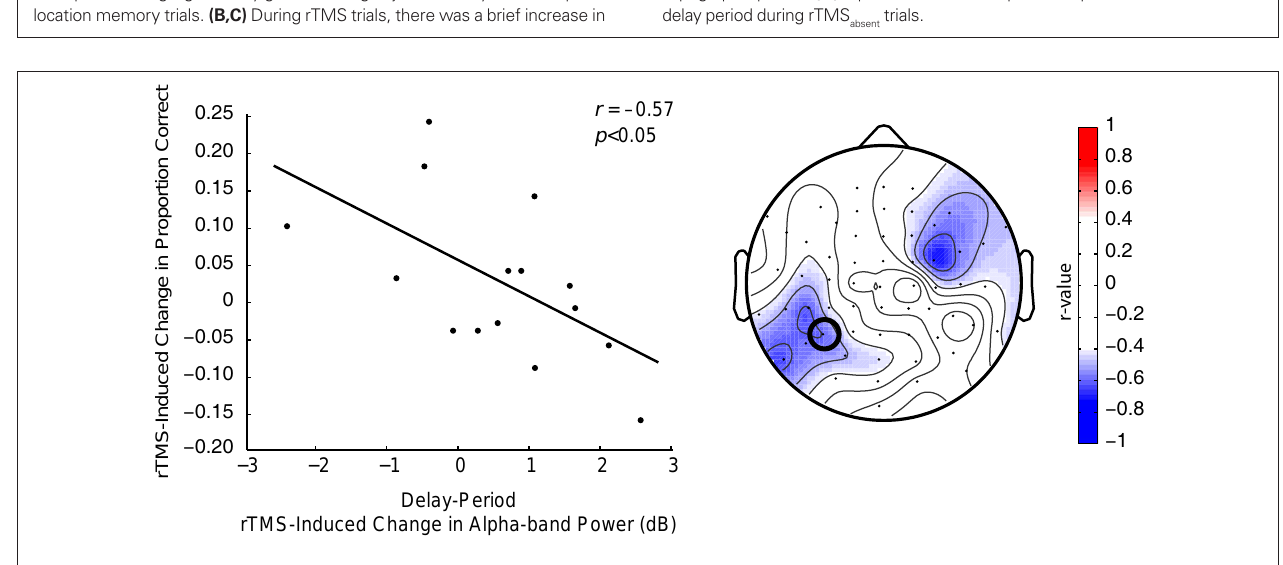
FIGURE 3 | Effect of rTMS on delay-period alpha-band power. (A) During the delay-period there was an increase in power between 10 and 15 Hz for both memory tasks, predominantly over posterior scalp regions. The magnitude of power change between the two memory conditions differed signifi cantly [mean difference across all channels: t (14) = 7.58; p < 10 − 5 ], with delay period alpha- band power being signifi cantly greater during object memory trials compared to location memory trials. (B,C) During rTMS trials, there was a brief increase in